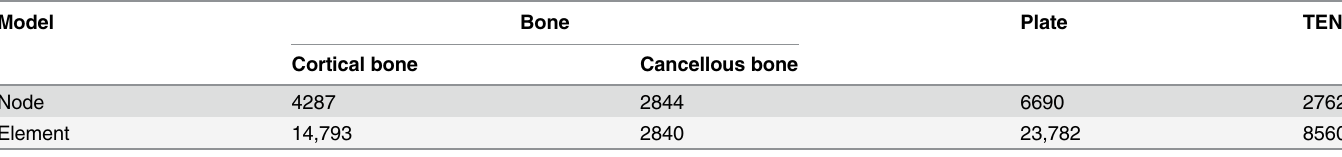
Table 1. Number of nodes and elements of bone and implants. Model